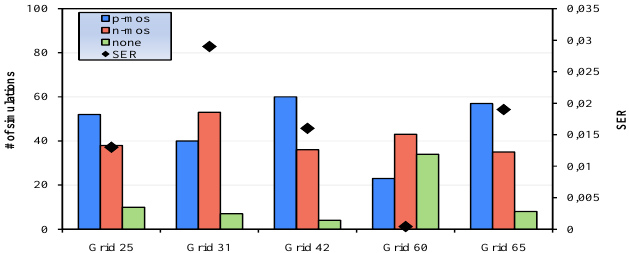
Figure 9. Number of affected transistors for 100 simulations for some grids of s15850 with the corresponding SER values.